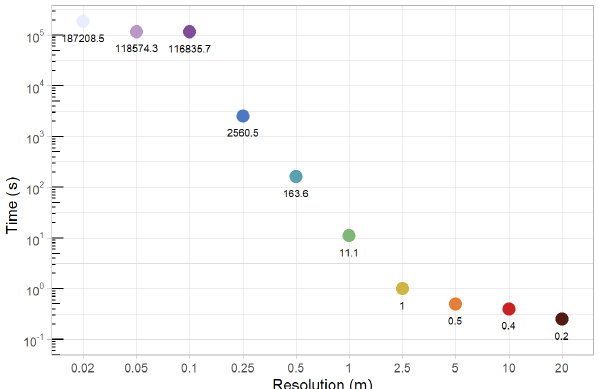
Figure A10. Variogram processing times for the 27 February 2020 observation day. Colors indicate different snow depth digital sur- face model (DSM) resolutions and the number labels are the vari- ogram processing times (in seconds) for each DSM. Note that fully processing the 0.05 and 0.02m grids was too computationally ex- pensive even when using a supercomputer. Therefore, we randomly sampled three million points from those DSMs before calculating the variograms. Thus, the processing times for 0.05 and 0.02m are